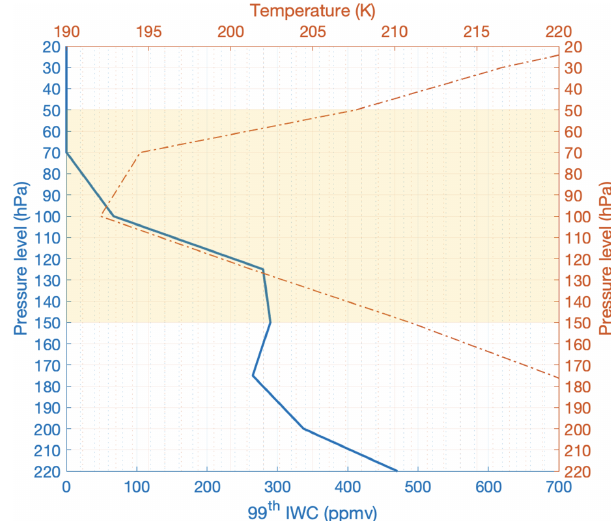
Figure 6. Profiles below and within the TTL (yellow shade) in the inner-domain D4 from ERA5 99th percentile of ice water content (solid blue line) and domain-mean temperature (dashed–dotted red line) at 10:00UTC on 10 August